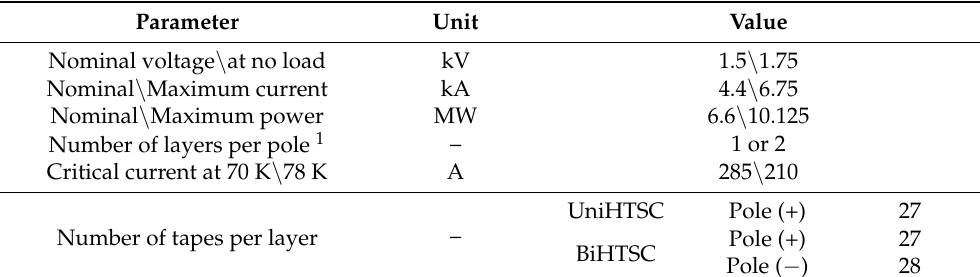
Table 4. Electrical parameters used for cable